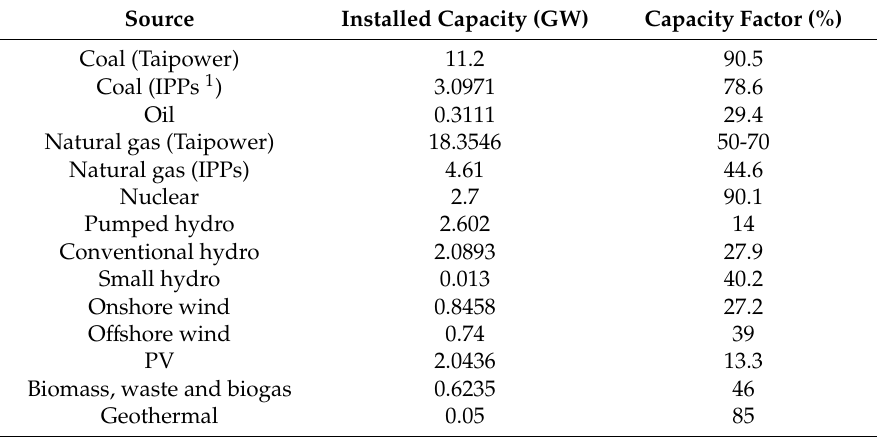
Table 2. Projected 2025 baseline generation capacity.